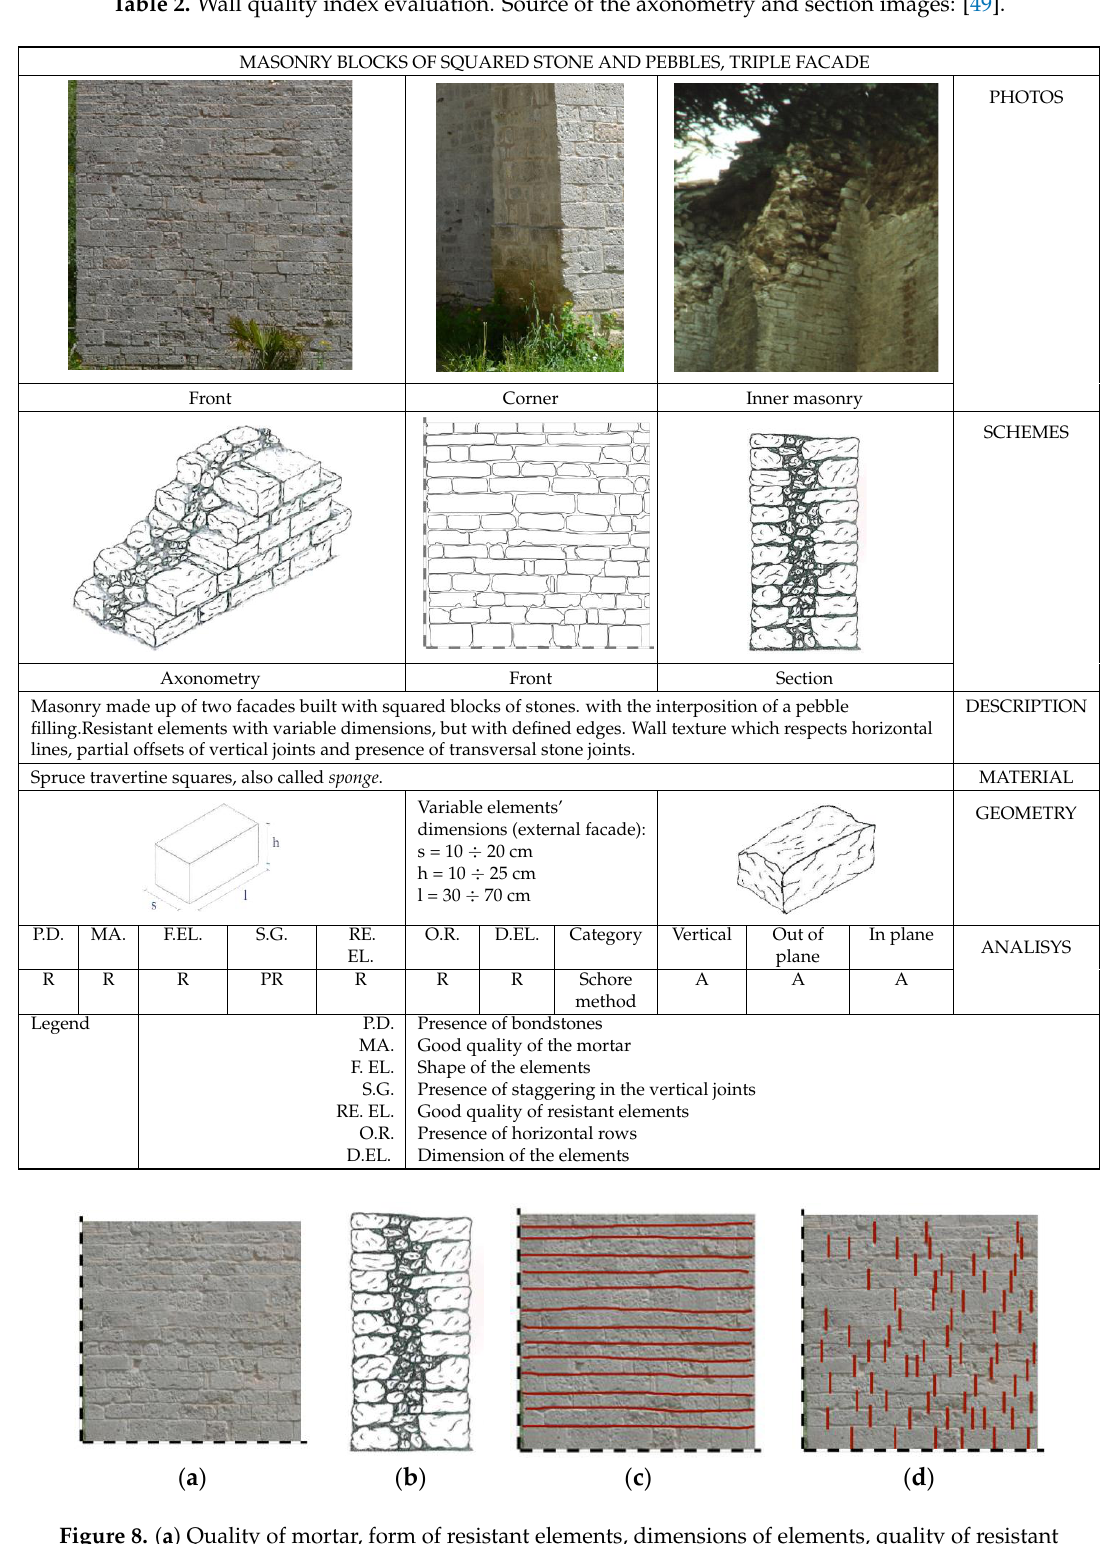
Figure 8. ( a ) Quality of mortar, form of resistant elements, dimensions of elements, quality of resistant elements; ( b ) presence of cross blocks [49]; ( c ) splitting of vertical joints; ( d ) presence of horizontal rows.